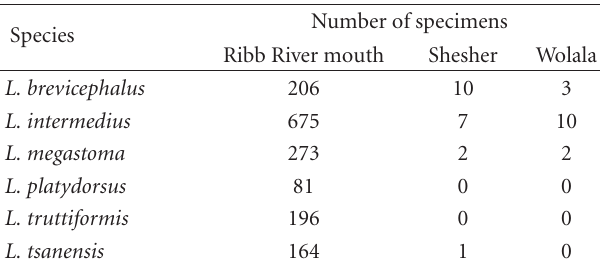
Table 4: The abundance of the six most dominant Labeobarbus species collected from Ribb River mouth, and their catch from Shesher and Welala wetlands.